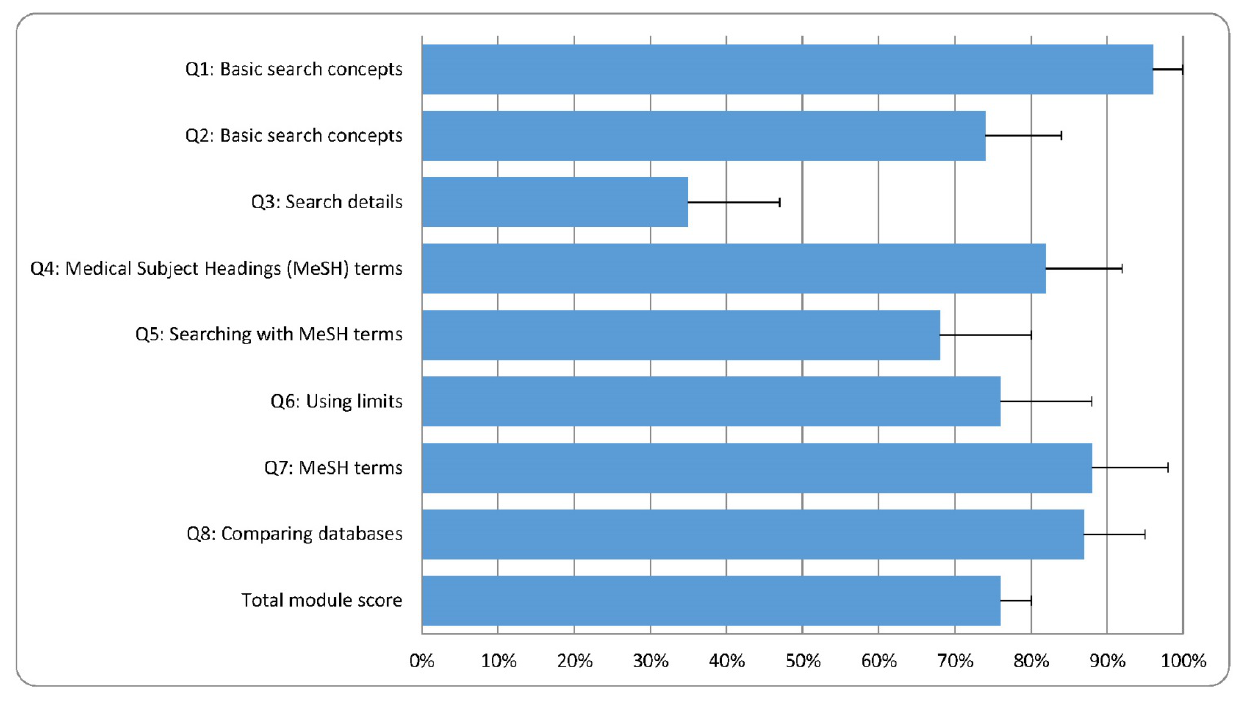
Figure 2 Total score and individual scores for module 2: “Finding Evidence in PubMed”*